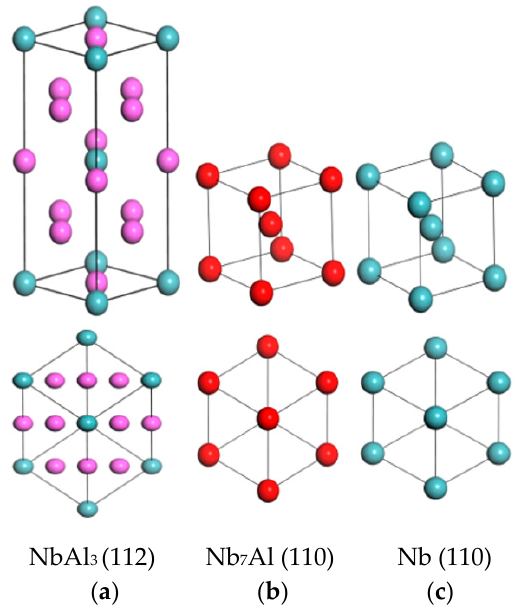
Figure 5. The X-ray diffraction for 2.60 km/s specimen.